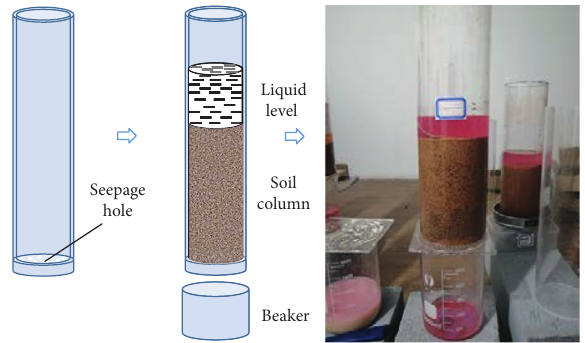
Figure 6: Experimental principle and device diagram.